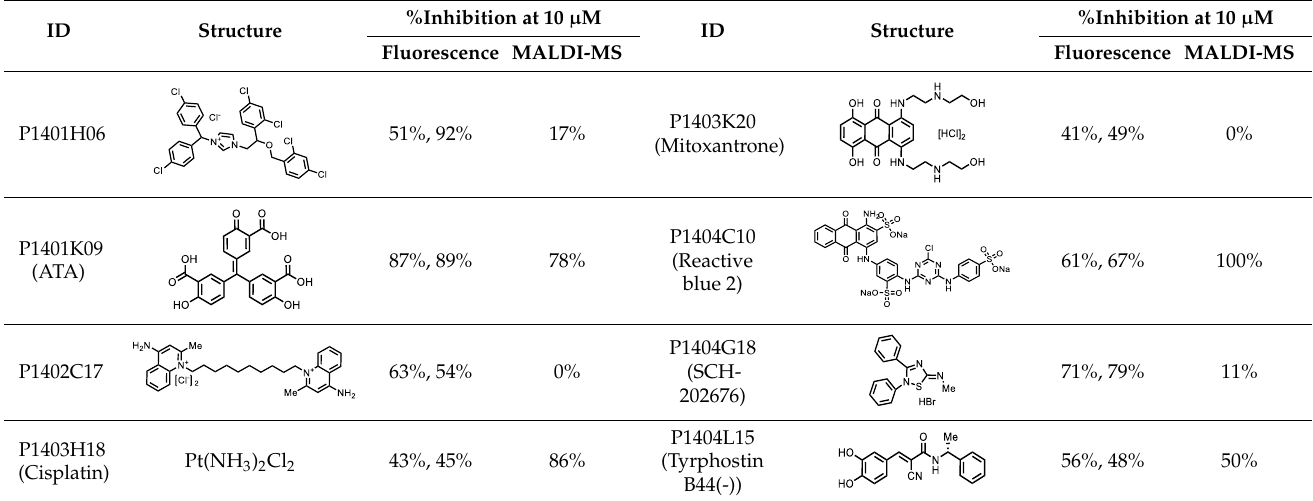
Table 1. %Inhibition at 10 μM of hits from the LOPAC pilot screen.